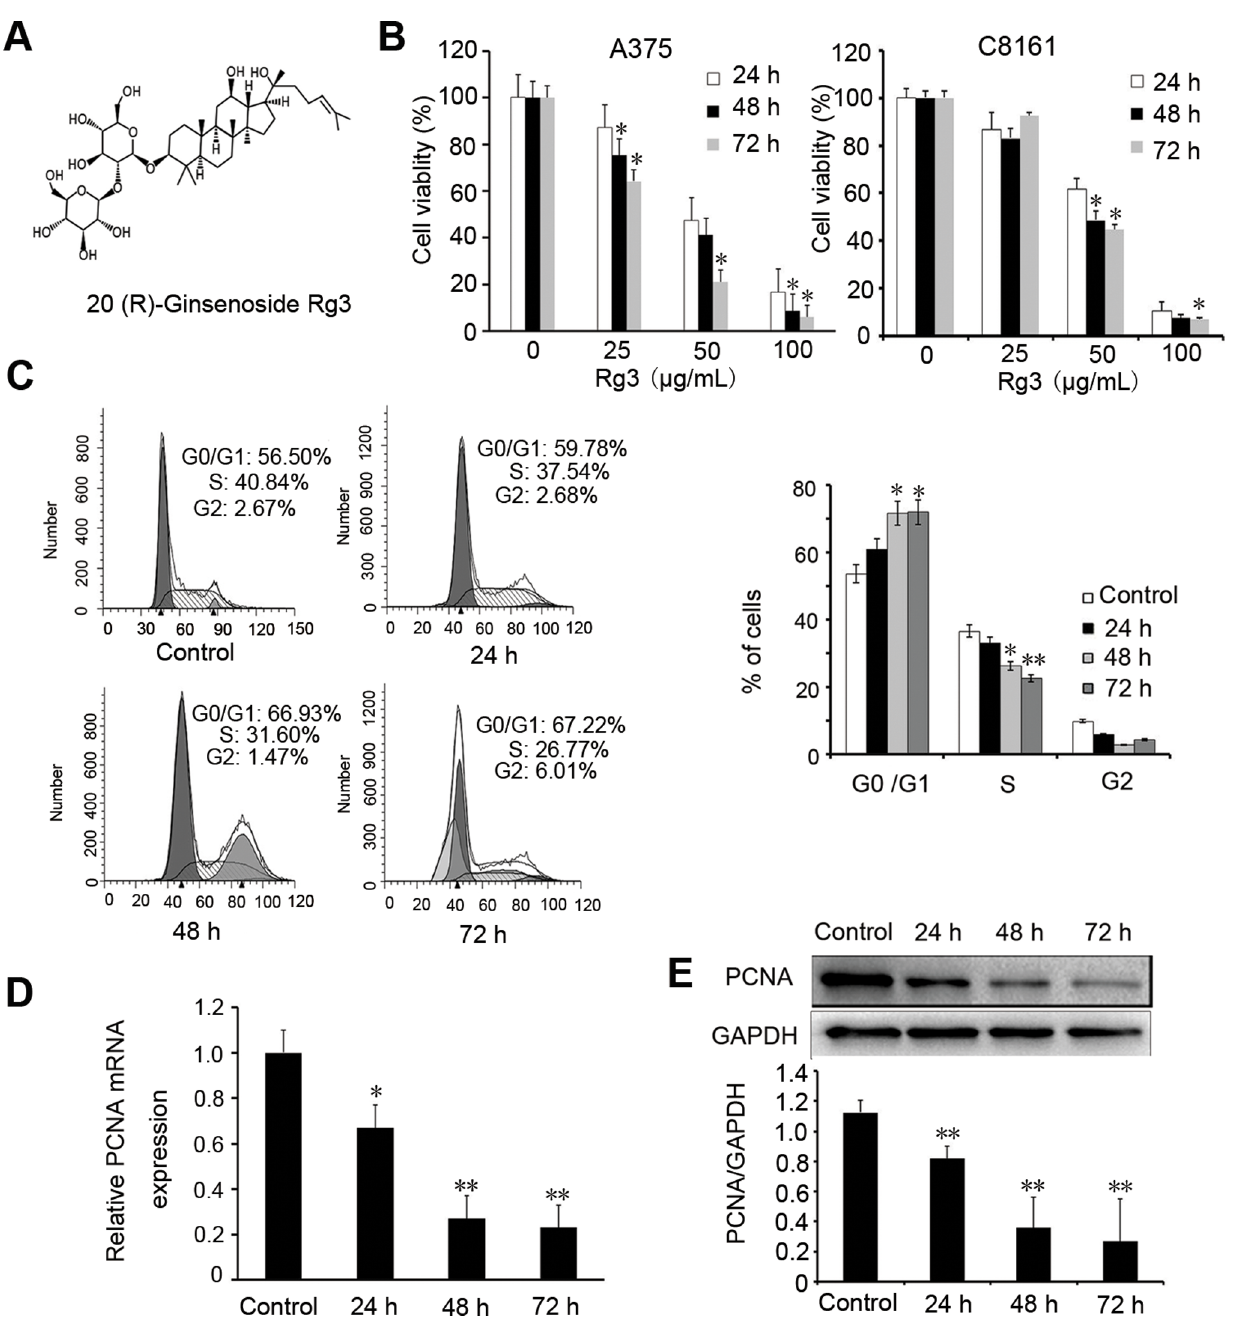
Fig. 2. Rg3 inhibits melanoma cell growth. (A) Structure of 20 (R)-Ginsenoside Rg3. (B) A375 and C8161 cells were treated with Rg3 (0, 25, 50, 100 m g/ mL) for 24, 48 or 72 h. Cell viability was determined by CCK-8 assay as described in Materials and Methods. (C) Cell cycle analysis. A375 cells were treated with Rg3 (50 m g/mL) for 0, 24, 48 or 72 h and were analyzed by a FACScan flow cytometer. Group data analysis was shown. (D) The mRNA level of PCNA was detected by real-time PCR in A375 cells. (E) Western blotting was employed to examine PCNA protein expression in A375 cells. GAPDH was used as an internal control. The statistical analyses for Western blotting were shown. Data were presented as the mean ¡ S.D. of three independent experiments. *, p , 0.05; **, p , 0.01.